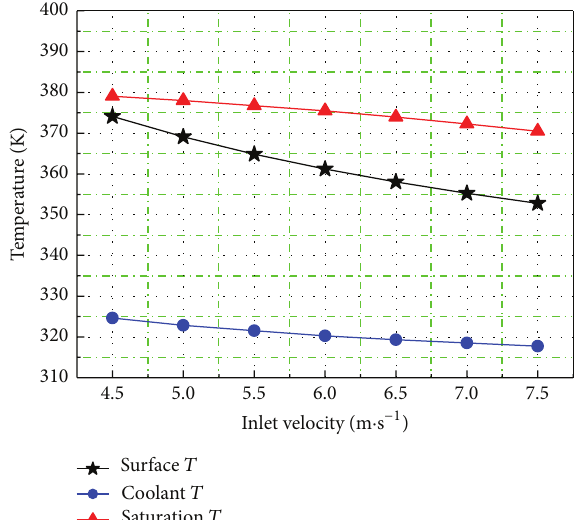
Figure 12: Temperatures of cladding surface, coolant, and saturation against coolant velocity for standard fuel assembly.